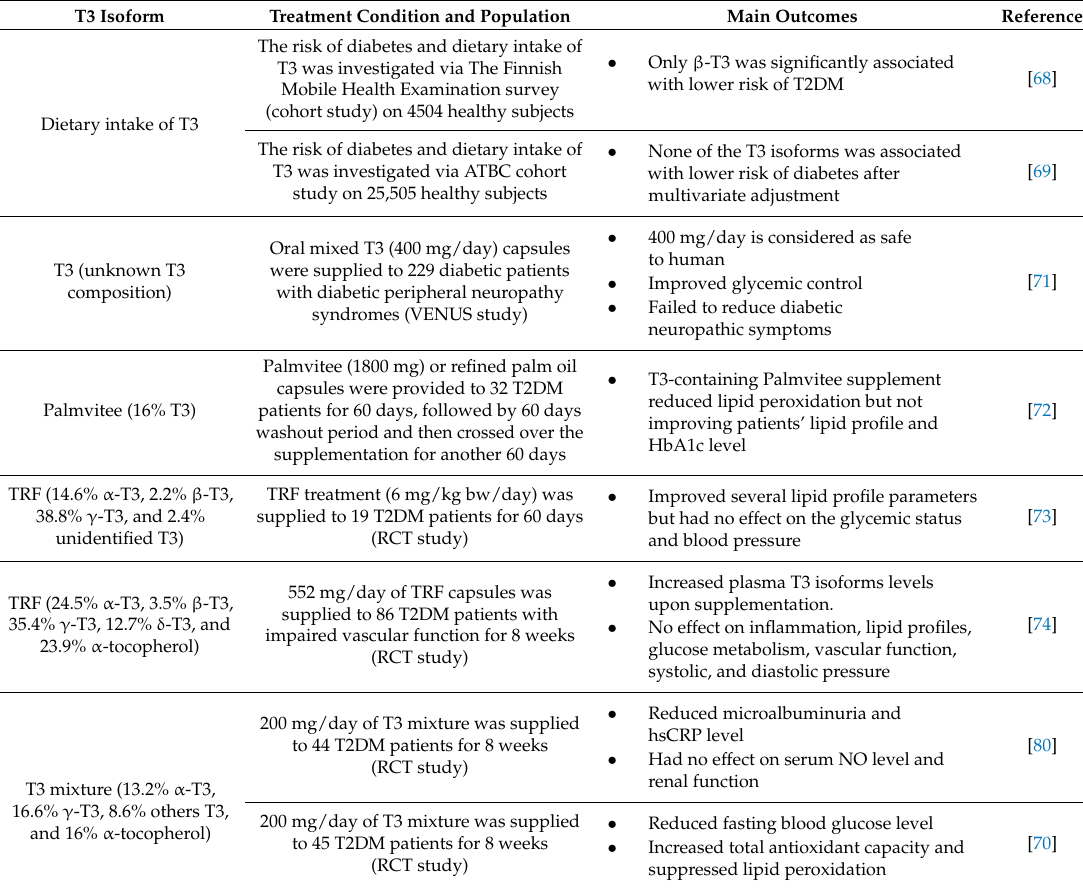
Table 1. Summary of the antidiabetic effects of T3 from human